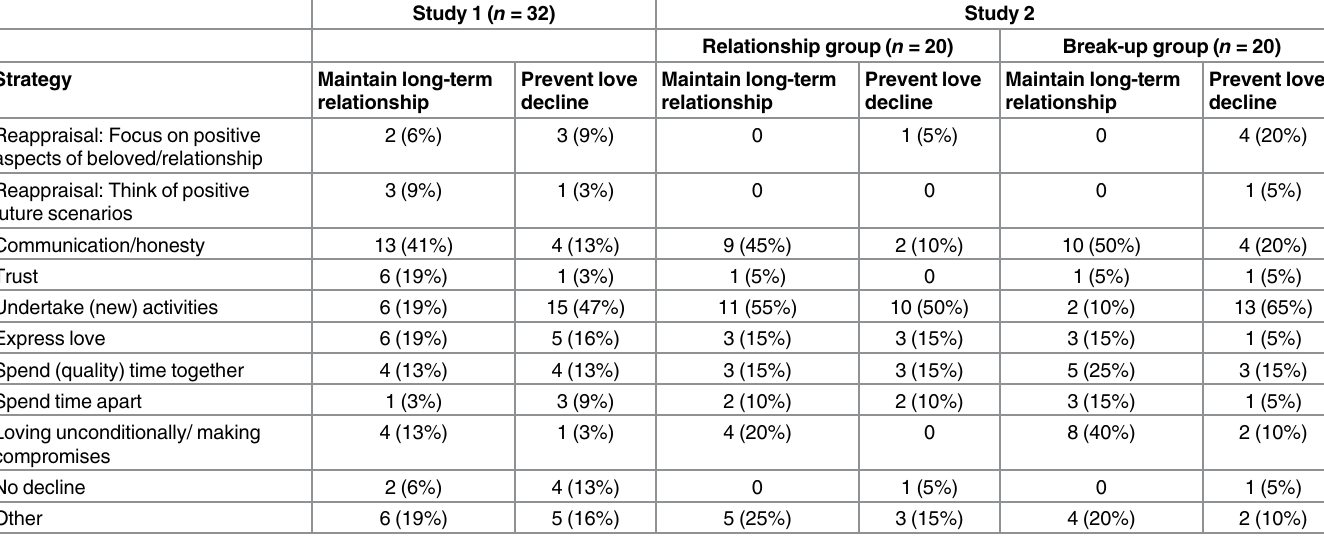
Table 2. Counts and percentages of participants reporting the use of certain regulation strategies in the context of long-term